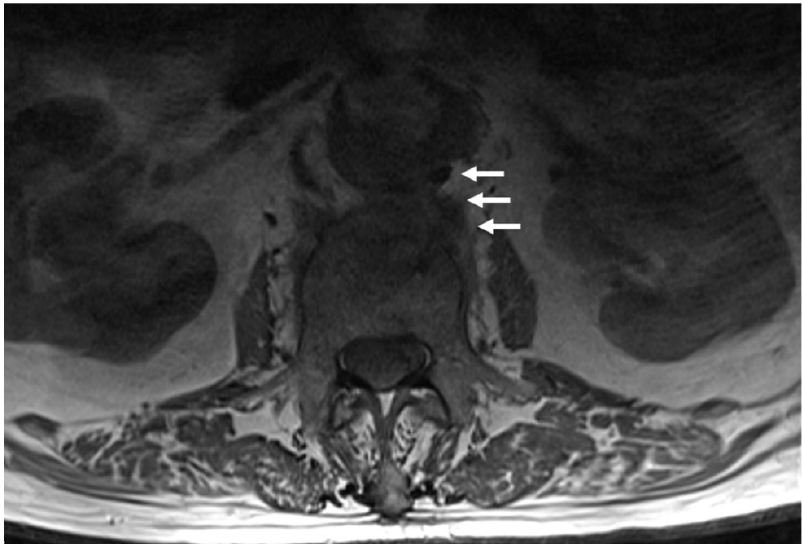
Figure 1: A 93-year-old man presented with low back and right leg pain, malaise and low-grade fever of 4 month duration; he had an abdominal aortic aneurysm treated with vascular graft 18 years before. Axial T1-weighted MR image of the lumbar spine shows pathological signal intensity of the L3 vertebral body, and continuous abnormal soft tissue of similar signal intensity extending from the posterior aneurysmal sac to L3 vertebral body ( arrows ). The aortic lumen is irregular, with flame-shaped areas of pointing contrast suggesting inflammatory infiltration into the aortic wall. With the presumptive diagnosis of infection, he was treated by his local physicians with antibiotics (ciprofloxacin and rifampicin) and analgesics, in addition to lumbar spine immobilization with a brace. CT-guided biopsy was done at his admission; cultures were negative, probably because of antibiotics administration. Because of deteriorated general health status, a joint decision was obtained for conservative treatment with long term suppression with antibiotics. Four months later, the patient is afebrile with improved but constant low back